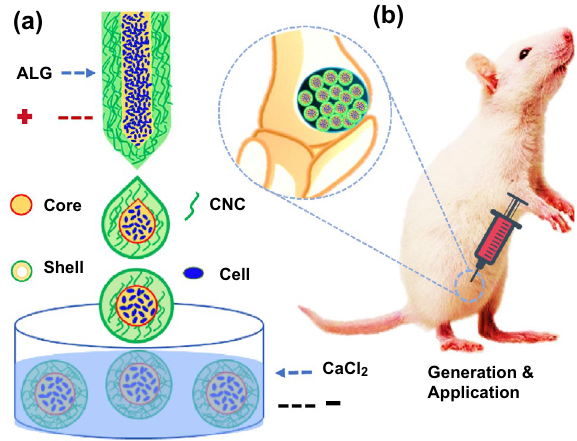
Fig. 1 Schematic illustrations of the generation and application of the stem cell-laden microcapsules. a The microcapsules